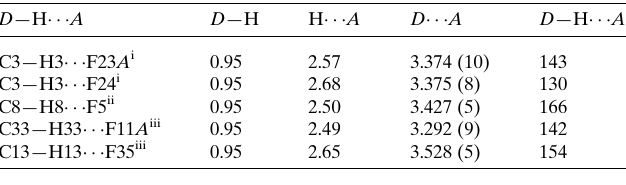
Table 1 Hydrogen-bond geometry (A˚ , (cid:4) ).